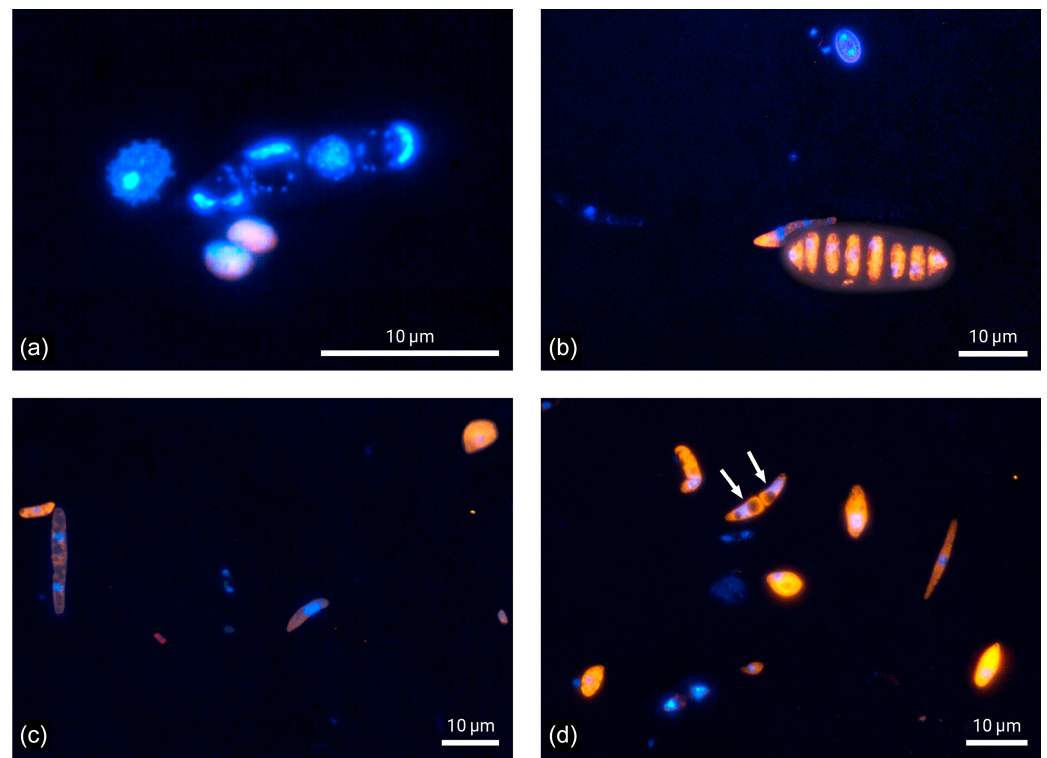
Figure 4. Microscopic images of fluorescence signals after DNA staining with DAPI (blue) and FISH (eukaryotes in orange and bacteria in red). Bioaerosol samples were collected at 5m height. Except for one bacterial bioaerosol in (c) , all other fluorescent bioaerosol signals in these panels were attributed to the eukaryotic